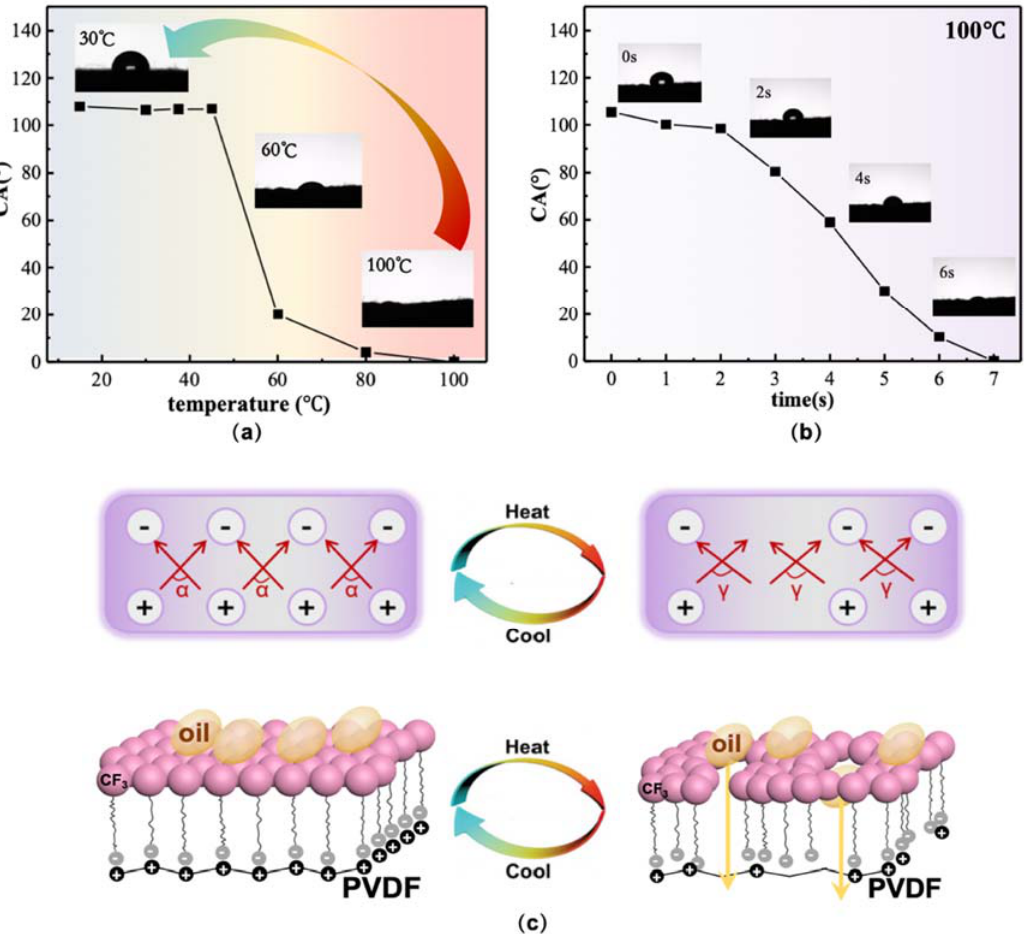
Figure 3. The oleophobic effect and its reversibility of SPFO-coated PVDF fibre membranes under different temperatures. ( a ) The oil contact angles of SPFO-coated PVDF fibre membranes at different temperatures. ( b ) The oleophobic effect at exposure time at 100 ◦ C. ( c ) The reversible oleophobic- lipophilic switching mechanism of SPFO-coated PVDF fibre membranes with temperature